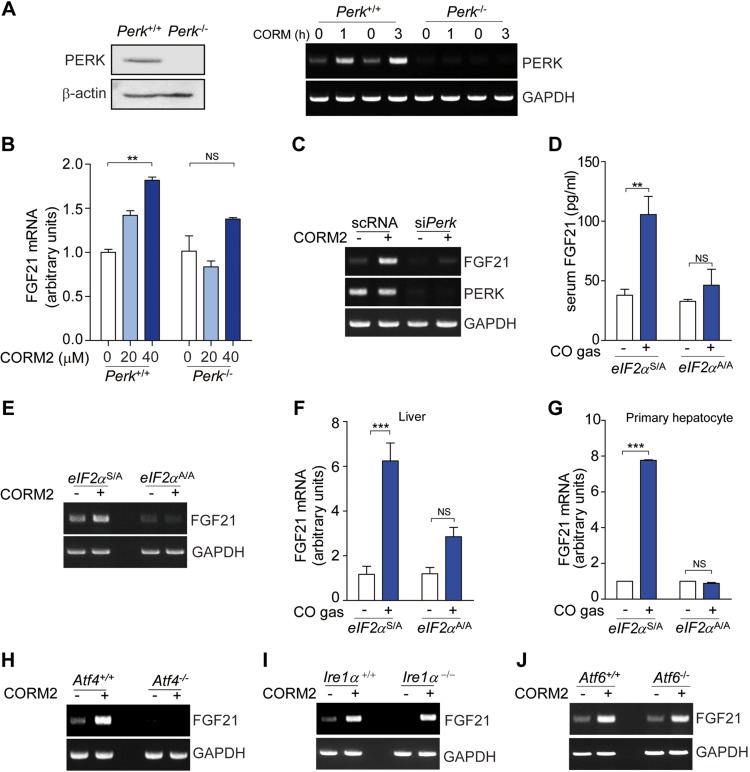
The expression of FGF21 regulated by CO is mediated by PERK signaling pathway. A, B) MEF cells from Perk+/+ and Perk−/− mice were treated with CORM2 (20 μM) for 1 and 3 h. Then, FGF21 mRNA expression was determined by RT-PCR (A). Perk+/+ and Perk−/− MEF cells were treated with CORM2 at various concentrations (0, 20, and 40 μM) for 3 h, and the mRNA level of FGF21 was measured by qRT-PCR (B). C) AML12 cells were transfected with scRNA and siRNA against Perk, and then, cells were treated with CORM2 (20 μM) for 3 h. mRNA levels of FGF21 and PERK were detected by RT-PCR. D–F) Heterozygous eIF2αS/A/fTg mice and eIF2A/A mutant mice were administrated CORM-2 for 3 h or CO gas (250 ppm) for 2 h. Serum FGF21 levels were assessed by ELISA (D), and mRNA levels in liver tissues were assessed by RT-PCR (E) and qRT-PCR (F). G) Primary hepatocytes isolated from heterozygous eIF2αS/A/fTg mice and eIF2A/A mutant mice were treated with CO gas for 2 h, and the mRNA level of FGF21 was detected by qRT-PCR. H–J) Hepatocytes from Atf4+/+, Atf4−/−, Ire1+/+, Ire1−/−, Atf6+/+, and Atf6−/− mice were treated with CORM2 or RuCl2 as a control for ruthenium for 3 h to assess the mRNA expression of FGF21 by RT-PCR. Data are presented as means ± sem (n = 3). NS, not significant. **P < 0.01, ***P < 0.001.